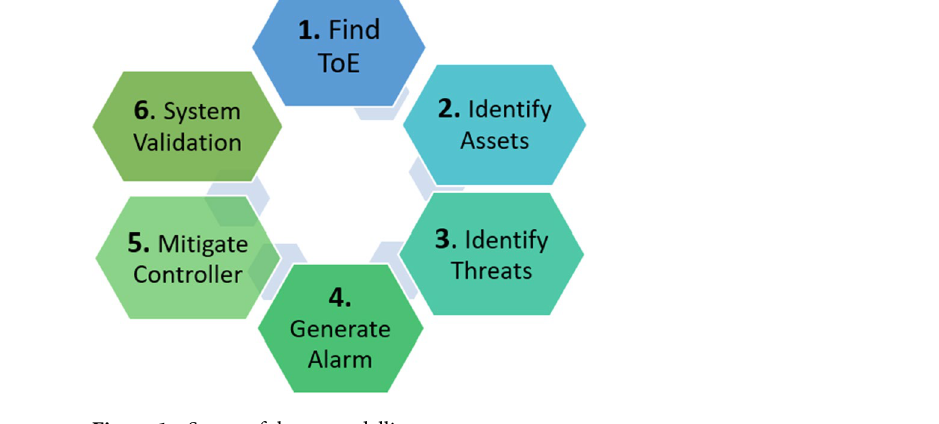
Figure 1. Stages of threat modelling